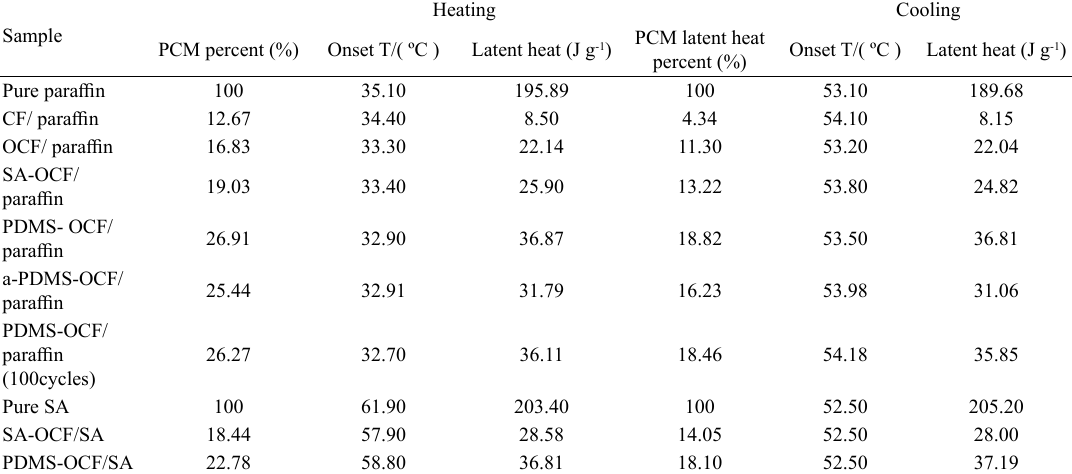
Figure 5. DSC curves for heating (a) and cooling (c) of pure paraffin, PDMS-OCF/paraffin, SA-OCF/paraffin, OCF/paraffin and CF/ paraffin; heating (b) and cooling (e) of PDMS-OCF/paraffin, PDMS-OCF/paraffin after 100 cycles of heating and cooling, and a-PDMS- OCF/paraffin; heating (c) and cooling (f) of SA, SA-OCF/SA and Table 1. Thermal properties of PCMs and PCM composites